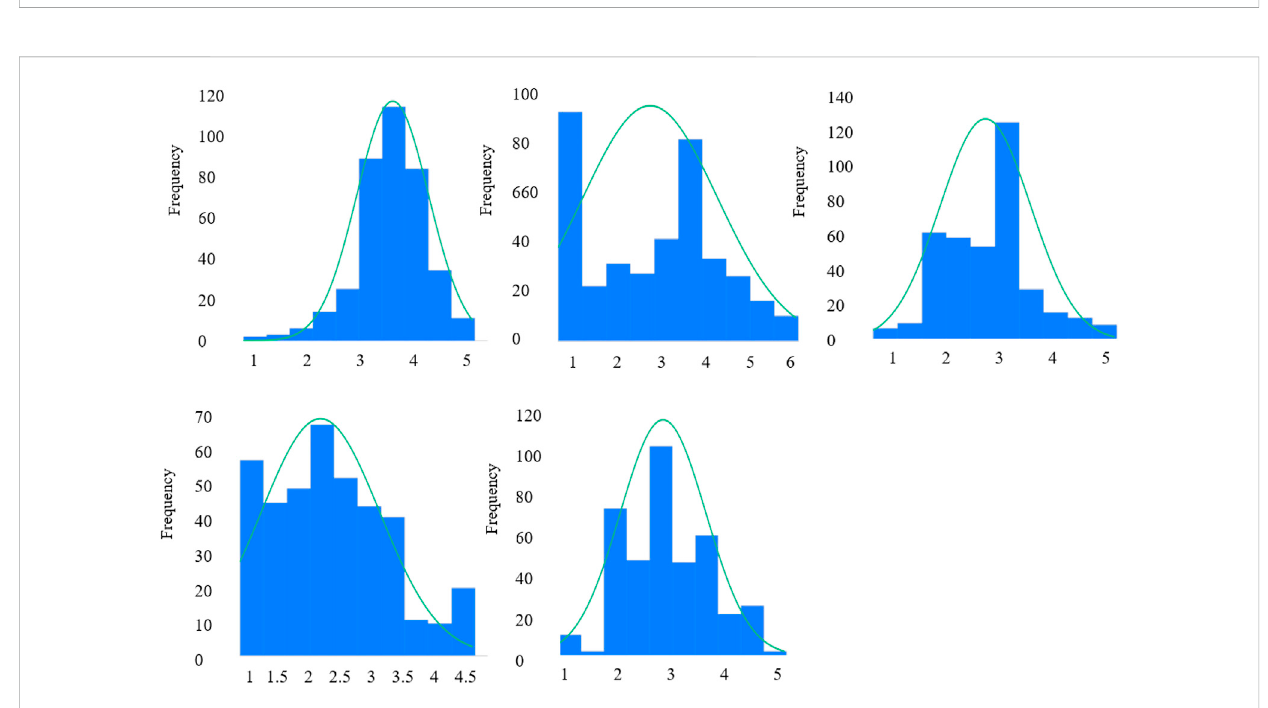
FIGURE 5 Normality test histograms for different